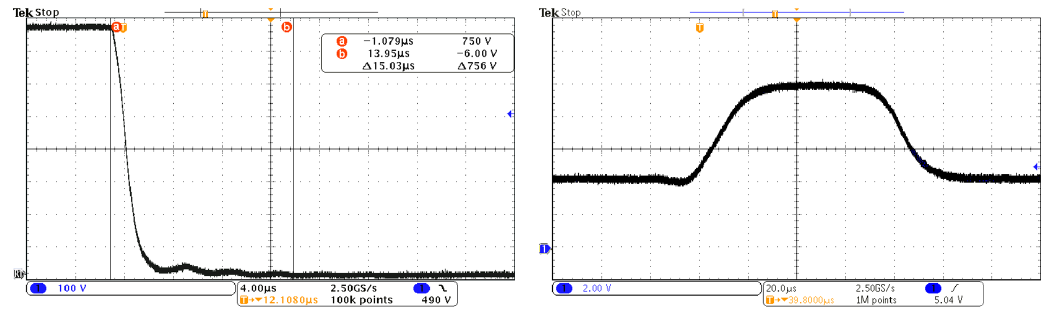
Figure 3. On the left: Measured actuator voltage (polarity reversed). The oscillogram shows a rapid decrease and a fast settling of the actuator voltage. On the right: Oscillogram of the light barrier signal. The projectile crosses the beam for approx. 100 µ s.